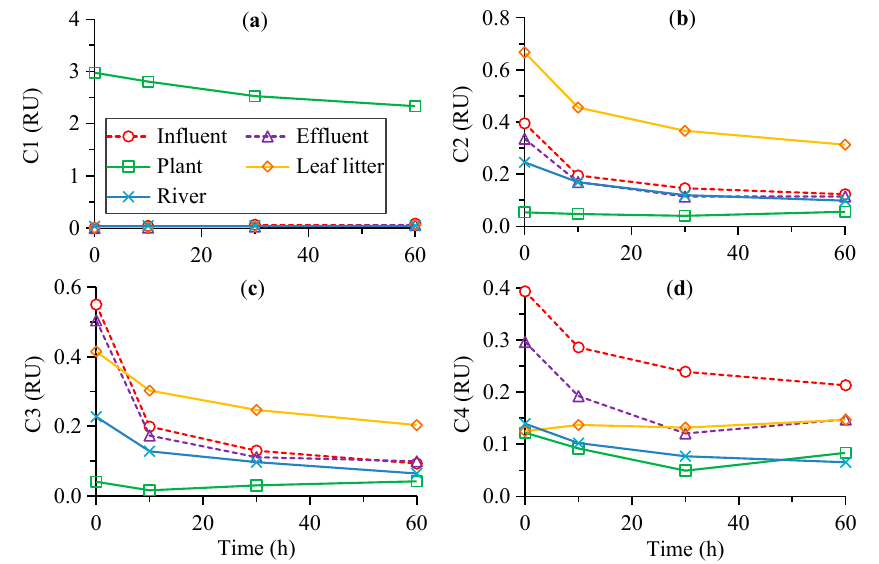
Figure 3. Changes in the fluorescence intensity of PARAFAC components (C1–C4, a – d ) with the